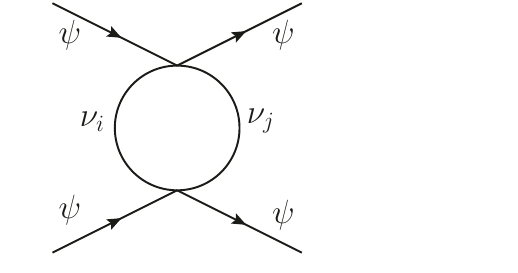
Figure 2 . Quantum forces can be induced from the exchange of two neutrinos. The two virtual neutrinos can in principle have di(cid:11)erent masses m i 6 = m j